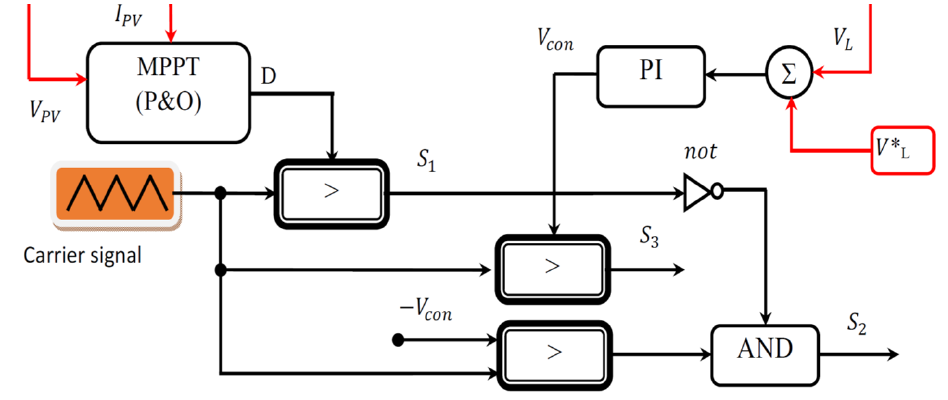
Figure 7. Control loop operation of proposed TPC. Table 1. Input and Output Specifications.